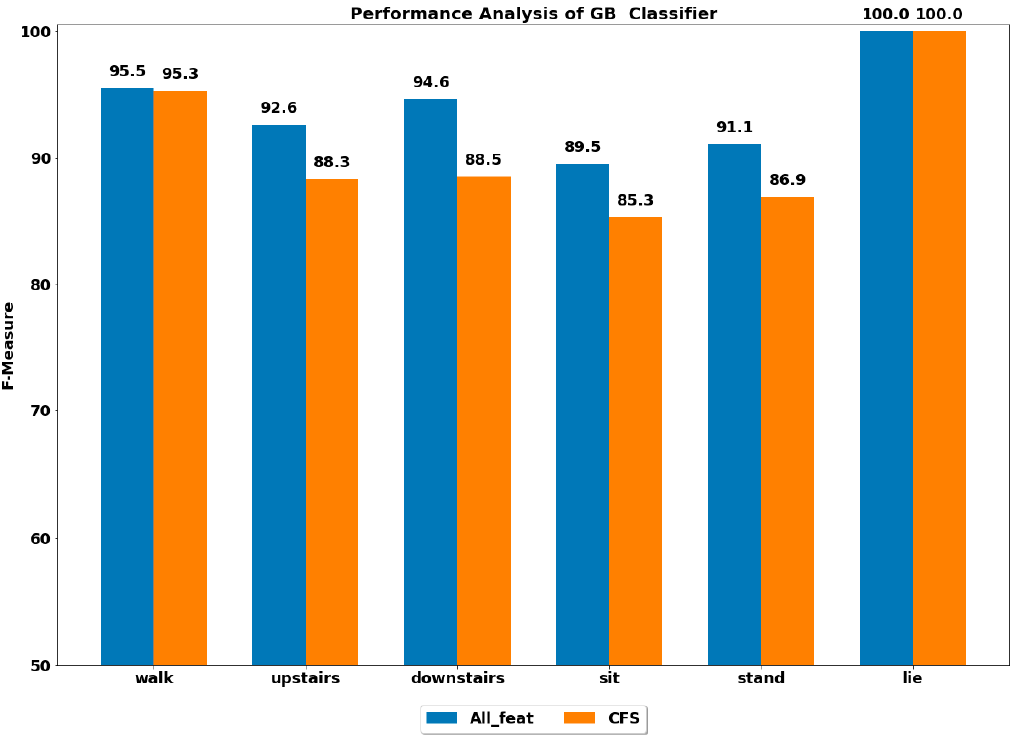
Figure 6. Performance analysis of CB (cat boosting) classifier with and without feature selection to classify set of ADLs.